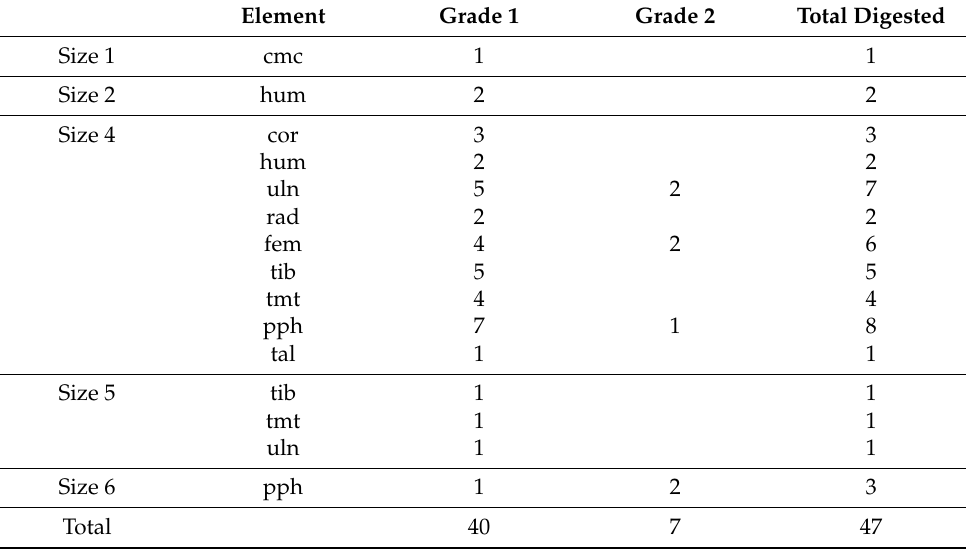
Table 3. Digestion grades observed at layer VIII of Grotte Vaufrey by skeletal elements. cor: coracoid; hum: humerus; rad: radius; uln: ulna; cmc: carpometacarpus; fem: femur; tib: tibiotarsus; tmt: tarsometatarsus; pph: posterior phalanx (talon excluded); tal: talon. Element Grade 1 Grade 2 Total